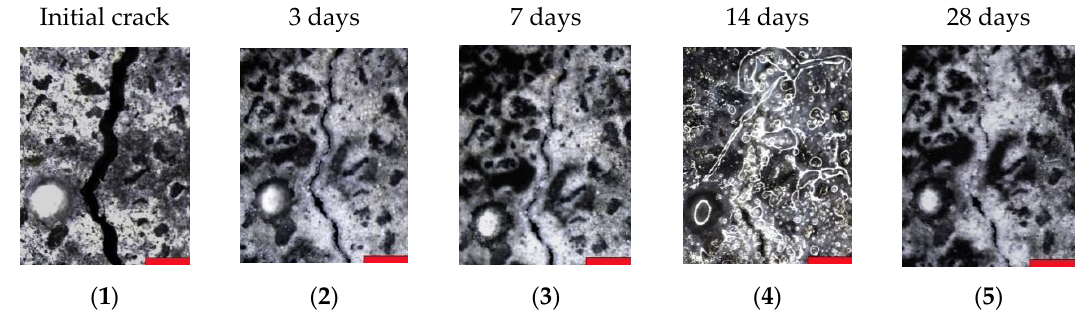
Figure 6. Evolution of crack closure as seen in microscopic images of a SAP sample at ( 1 ) initial measurement and after ( 2 ) 3 days, ( 3 ) 7 days, ( 4 ) 14 days and ( 5 ) 28 days of wet-dry cycles. Clear crystals are formed in the SAP-containing specimen. The scale bar at the bottom right of every micrograph represents 500 µm.